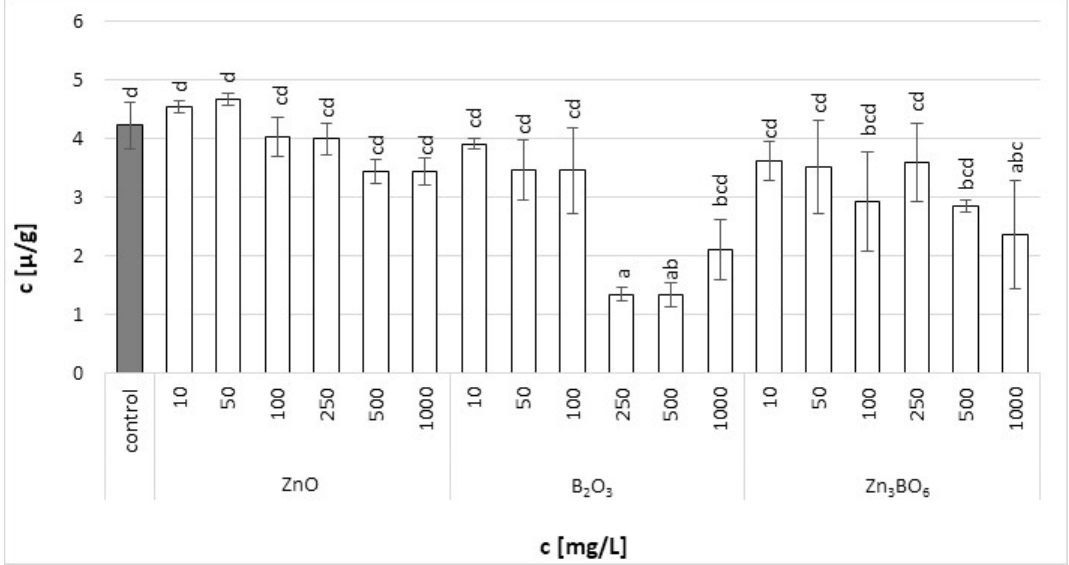
plants grew in Steinberg solution; standard deviation is represented as ± S.D. ( n = 3), and two-way ANOVA test with Dunnett’s multiple comparisons was applied.